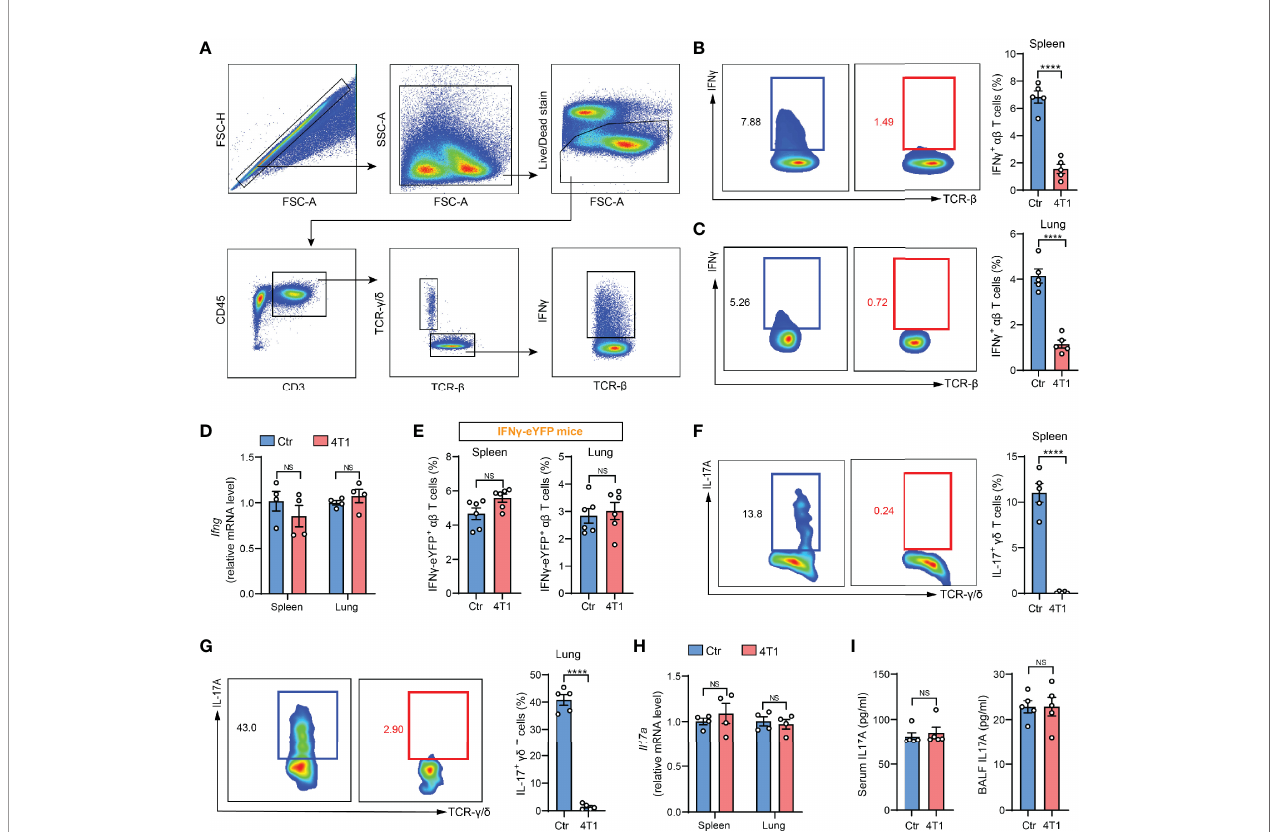
FIGURE 1 | A discrepancy was found between ICS and other cytokine detection methods in assessing T cell responses in the mouse model of breast cancer. (A) Gating strategy for spleen IFN g + ab T cells in fl ow cytometric analysis. Arrows indicate the parent population that the subsequent plots are gated on. (B, C) ICS analysis of the frequencies of IFN g + ab T cells in crude spleen (B) or lung (C) samples from naïve control (Ctr) or 4T1 tumor-bearing mice (n=5 per group). (D) Relative mRNA levels of Ifng in puri fi ed spleen or lung ab T cells from control or 4T1 tumor-bearing mice (n=4 per group). (E) The frequencies of spleen or lung IFN g -eYFP + ab T cells in control or 4T1 tumor-bearing mice (n=6 per group) were quanti fi ed by living cell immunostaining and fl ow cytometry. (F, G) ICS analysis of the frequencies of IL-17 + gd T cells in crude spleen (F) or lung (G) samples from control or 4T1 tumor-bearing mice (n=5 per group). (H) Relative mRNA levels of Il17a in puri fi ed spleen or lung gd T cells from control or 4T1 tumor-bearing mice (n=4 per group). (I) IL-17A levels in serum ( left ) or lung BALF ( right ) from control or 4T1 tumor-bearing mice (n=5 per group) were measured by ELISA. Values of n represent biologically independent animals. Data are mean ± s.e.m. P values were calculated using unpaired t-test. **** P < 0.0001. NS, not signi fi